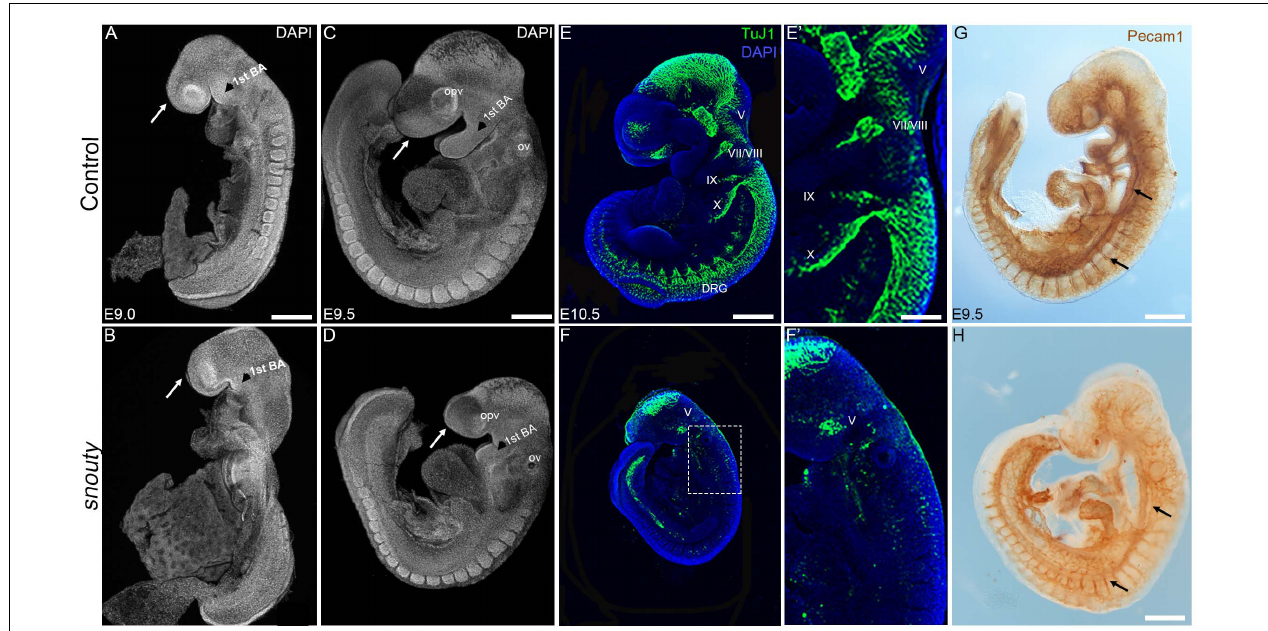
FIGURE 1 | snouty embryos exhibit small body size and craniofacial defects at E9.5. (A–D) Control and snouty mouse embryo littermates at E9.0 and E9.5 were stained with DAPI and imaged with a confocal microscope demonstrating the smaller body size and shortened frontonasal prominences (arrows) in snouty embryos. (E–F (cid:48) ) Neuronal marker TuJ1 staining of control and snouty embryos at E9.5 suggests that snouty embryos exhibit disrupted cranial ganglia. (E (cid:48) ,F (cid:48) ) Are higher magnification images of (E,F) . (G,H) PECAM1 immunostaining of E9.5 control and snouty embryos reveal abnormal development of the vascular tree like network in the head and epibranchial regions of snouty mutants. Intersomitic vessel formation (arrow, G,H ) is not affected.opv, optic vesicle; ov, otic capsules; BA, branchial arch; DRG, dorsal root ganglia. Scale bars for (A–D) is 300 um, (E,F) is 350 um, (G) is 300 um, (H) is 200